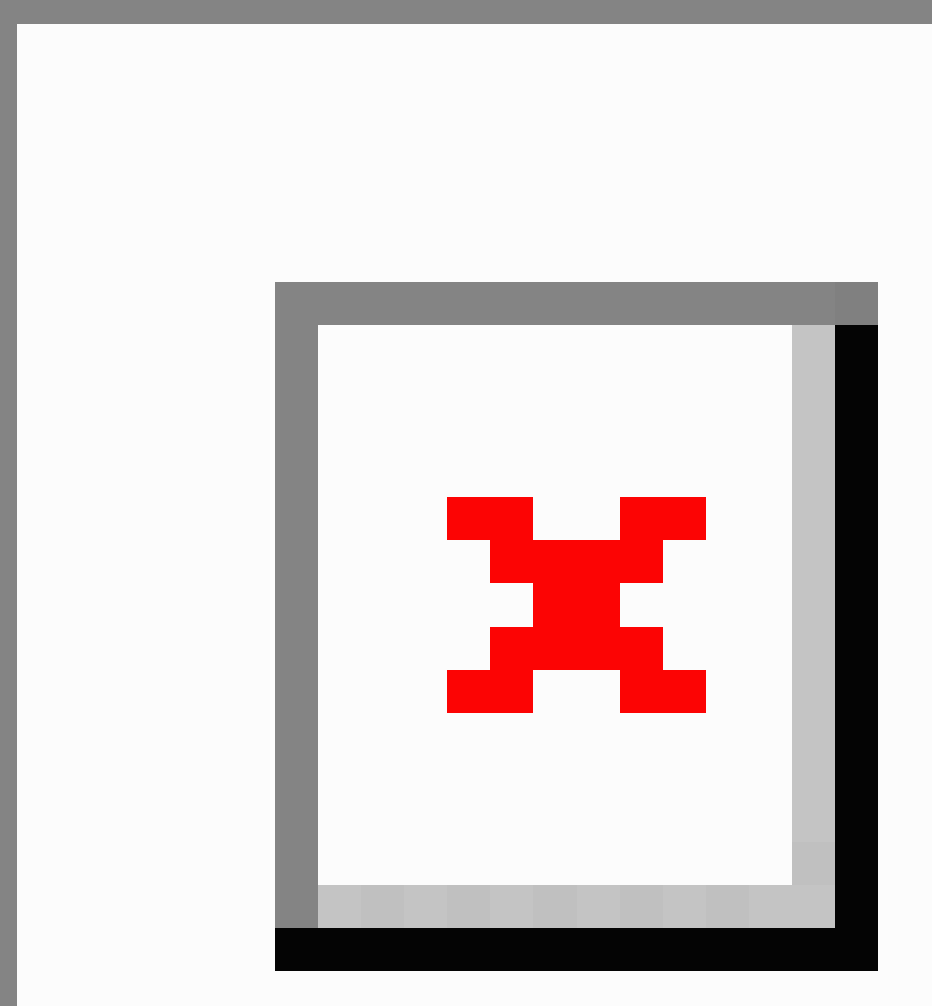
Figure 7. Reasons for participant inquiries to the ePOCS team over the study